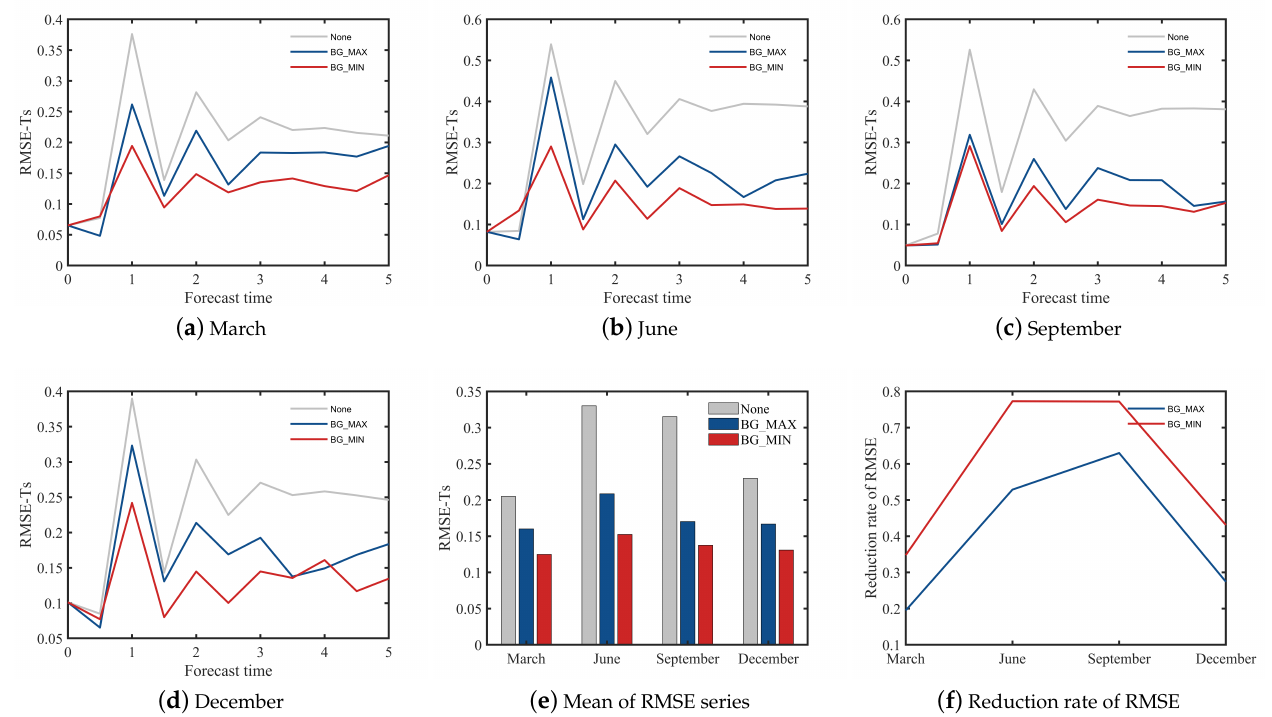
Figure 2. Comparison of analysis accuracy after introducing samples in BG_MAX and BG_MIN with obs_err = 10 − 3 .